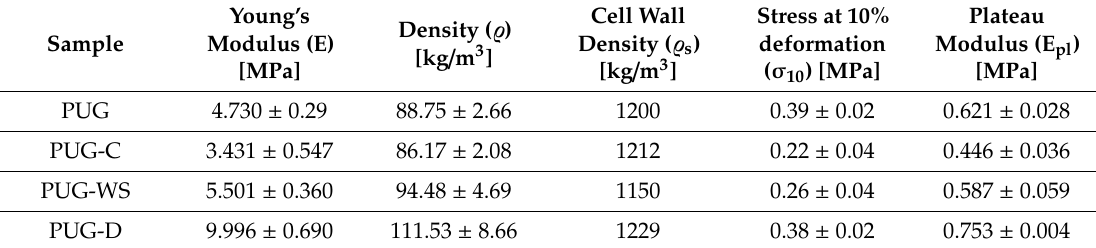
Table 6. Mechanical and structural properties of the